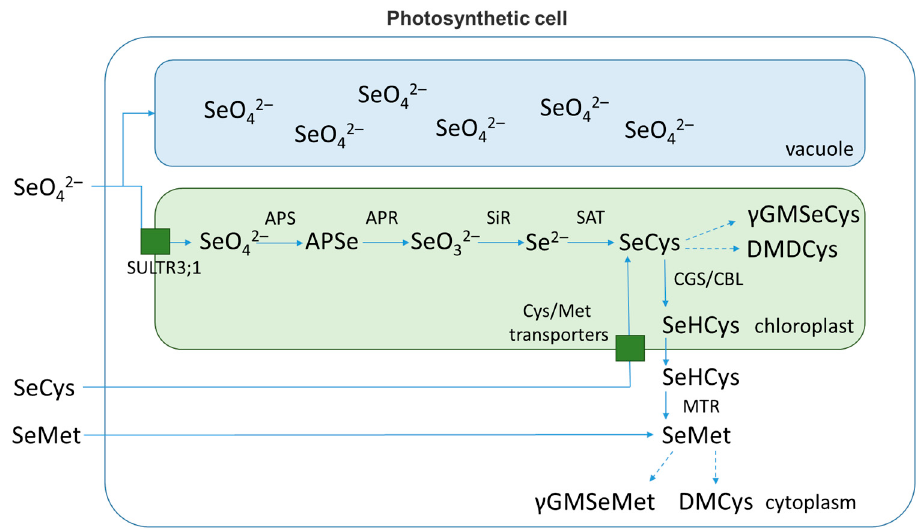
Figure 2. Metabolism of Se in